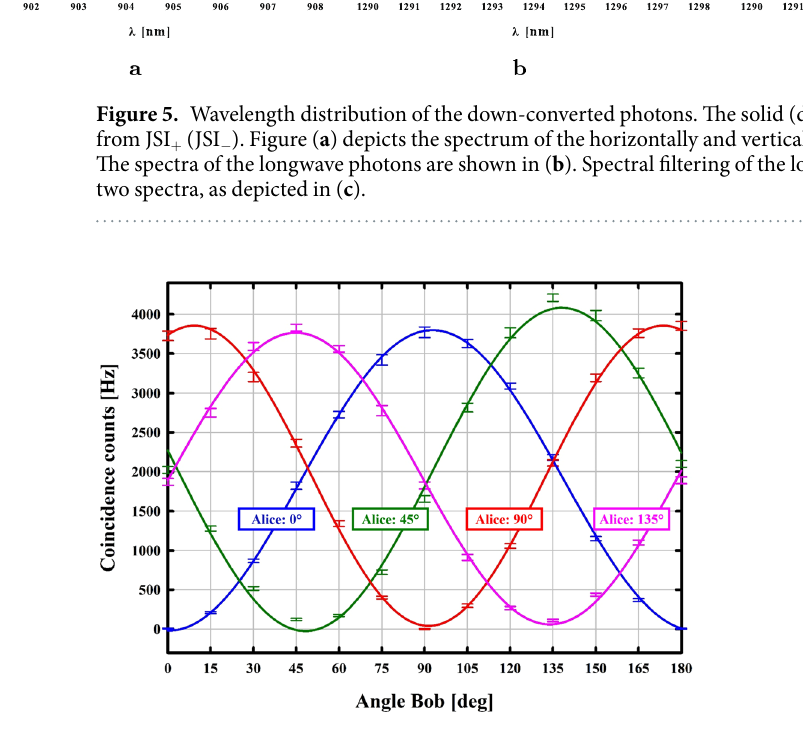
Figure 6. Measured coincidence counts and sinusoidal fit (solid lines) with respect to polariser settings. The visibilities in the H/V-basis (blue and red) and the diagonal basis (green and pink) are V H / V = 0.999(4) and V + / − = 0.971(6) respectively. The measurements were taken at a pump power of P = 8.3 mW and are averaged over approximately one minute; the error bars represent one standard deviation σ of the mean